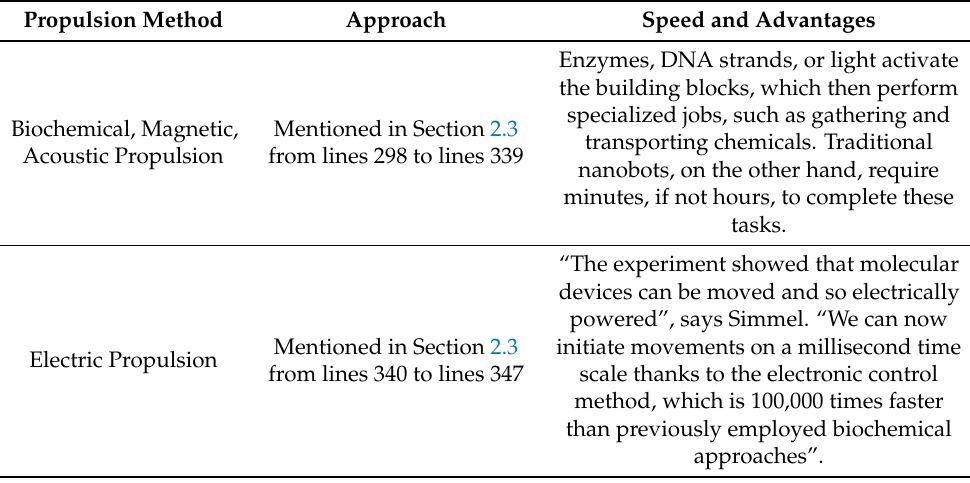
Table 2. Comparison between different propulsion techniques with respect to